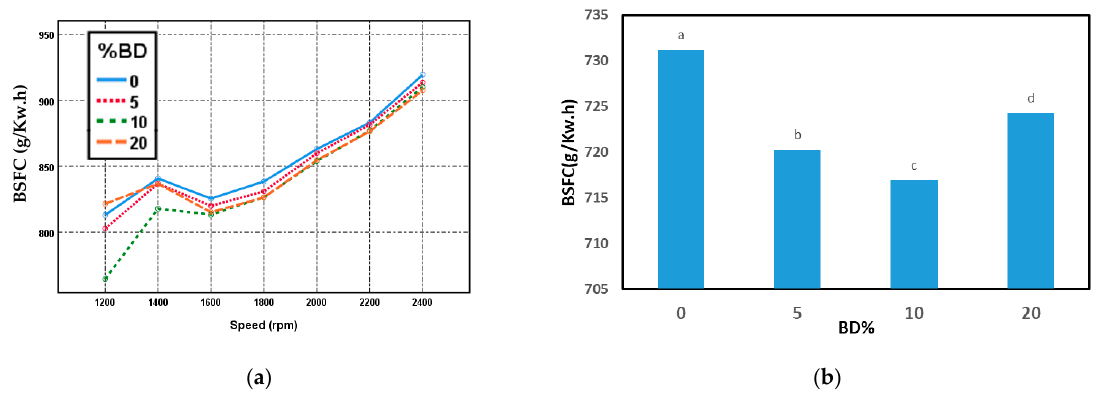
Figure 6. ( a ) Brake specific fuel consumption (BSFC) vs. S at 100% load; ( b ) mean values of total data of BSFC for di ff erent speeds and loads. The letters a-d inside the diagram indicate significant di ff erences ( P ≤